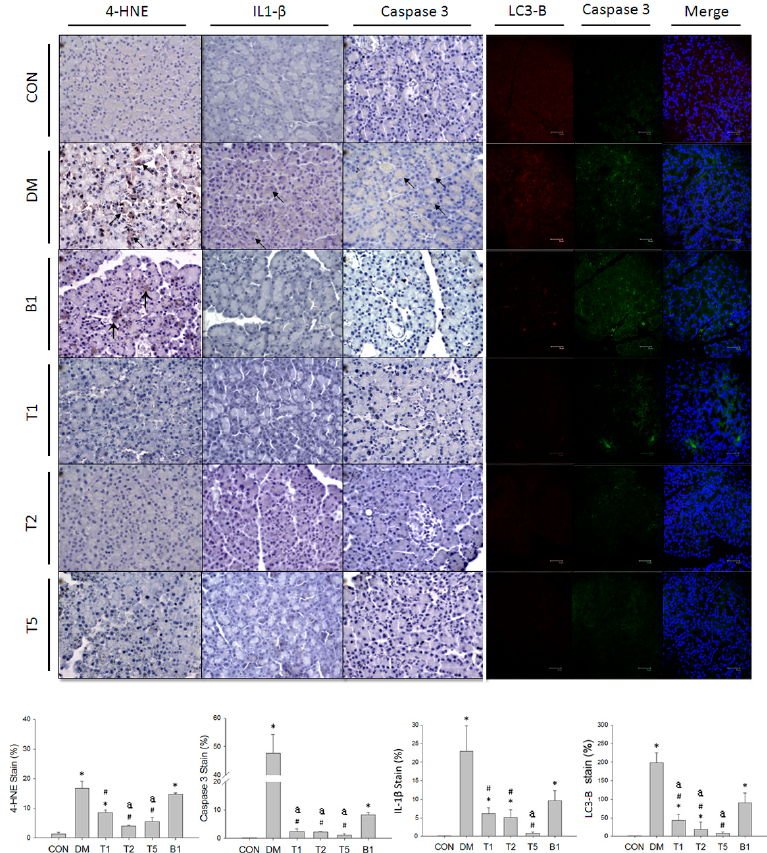
Figure 7. The typical graph of pancreatic expression (brown area indicated by arrows) of 4-HNE (lipid peroxidation and oxidative stress marker), IL-1 β (pyroptosis marker), caspase 3 (apoptosis marker) and fluorescent LC3-B (red color, autophagy marker) and caspase 3 (green color) in pancreas of six groups. Data are expressed as mean ± SEM. n = 3–5 each group. * p < 0.05 vs. CON. # p < 0.05 vs. DM. a p < 0.05 vs. B1.